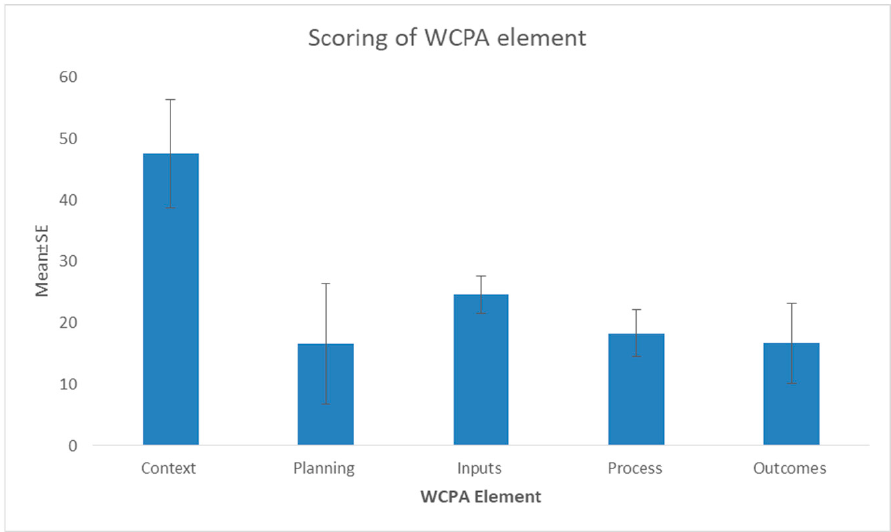
Figure 3. Scoring results of different elements of WCPA from participating protected areas in Paki- stan.